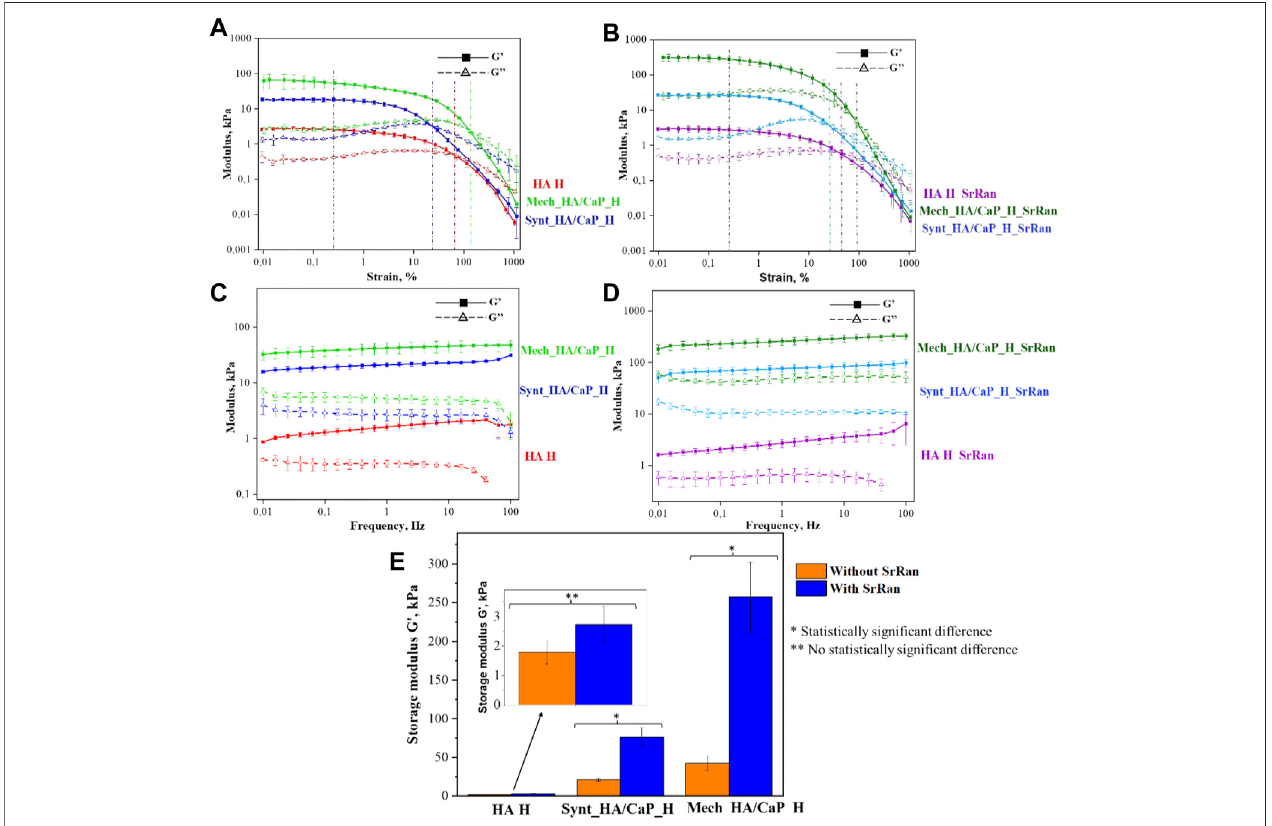
FIGURE6| Oscillatoryrheology. (A) AmplitudesweeptestofHA-containinghydrogelswithoutSrRanobtainedat1 Hzfrequency; (B) amplitudesweeptestofHA- containinghydrogelswithSrRanobtainedat1 Hzfrequency; (C) frequencysweeptestofHA-containinghydrogelswithoutSrRanobtainedat0.2%strain; (D) frequency sweep test of HA-containing hydrogels with SrRan obtained at 0.2% strain; (E) extracted mechanical stiffness of HA-containing hydrogels from frequency sweeps at 1 Hz and at 0.2%